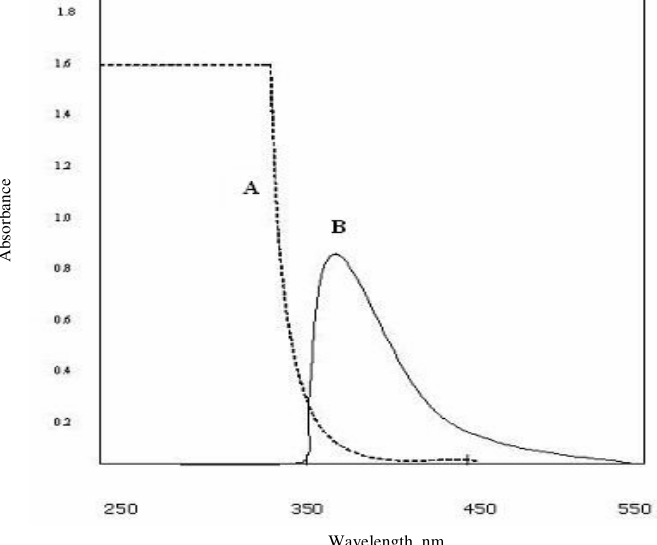
Figure 1. (a) Absorption spectrum of GPPH vs. ethanol blank (b) Absorption spectrum